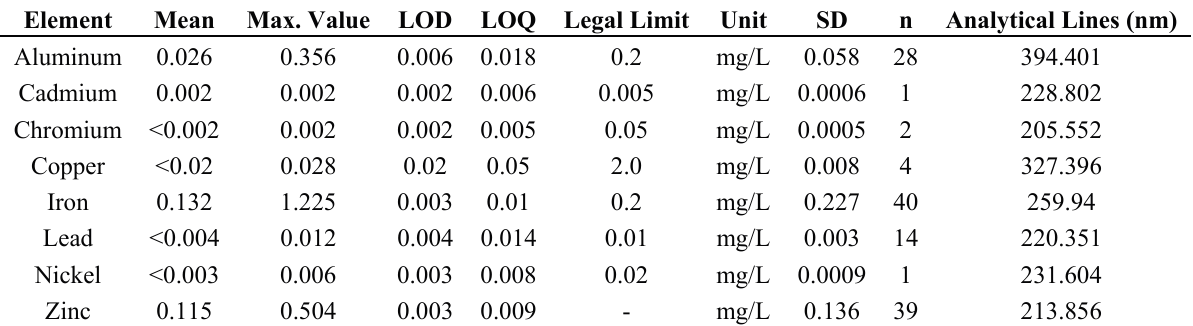
Table 5. Summary of the results in tap water sampled from localities, including the mean concentration, maximum mean value, limit of detection (LOD), limit of quantitation (LOQ), legal limit, standard deviation (SD), n (number of samples above LOD) and the best analytical wavelength.